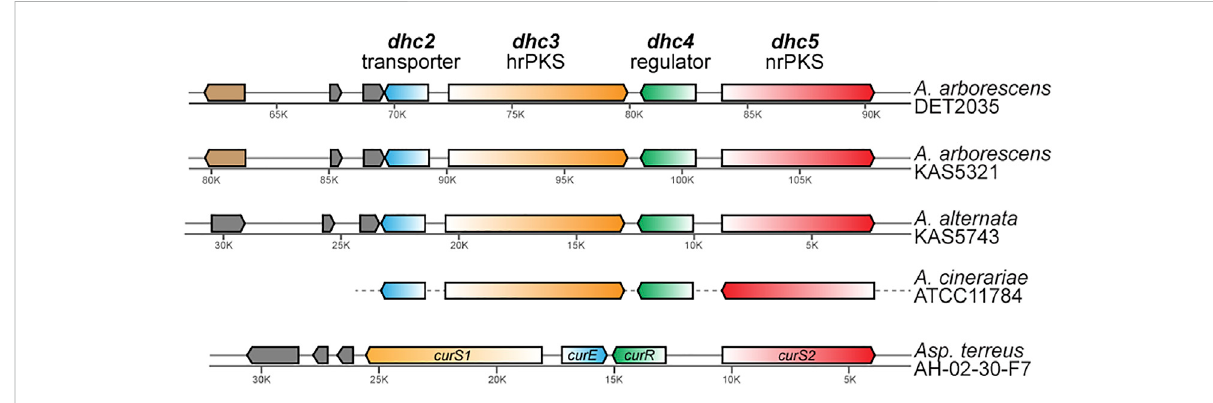
FIGURE 3 Comparison of homologous gene arrangement in the dehydrocurvularin BGC from the newly characterized Alternaria strains and previously characterized taxa ( A. cinerariae and Asp. terreus ). Genes with homologous sequence and predicted protein function are shown in the same color. The gene (light brown) that is unique to A. arborescens encodes for a glutamine-dependent NAD (+) synthetase. Genes shown in grey are not necessarilyhomologousandencodeforhypotheticalproteinsthatcurrentlylackanyfunctionalpredictions.Genearrangementsin A.cinerariae are as inferred by Cochrane et al. (2015).